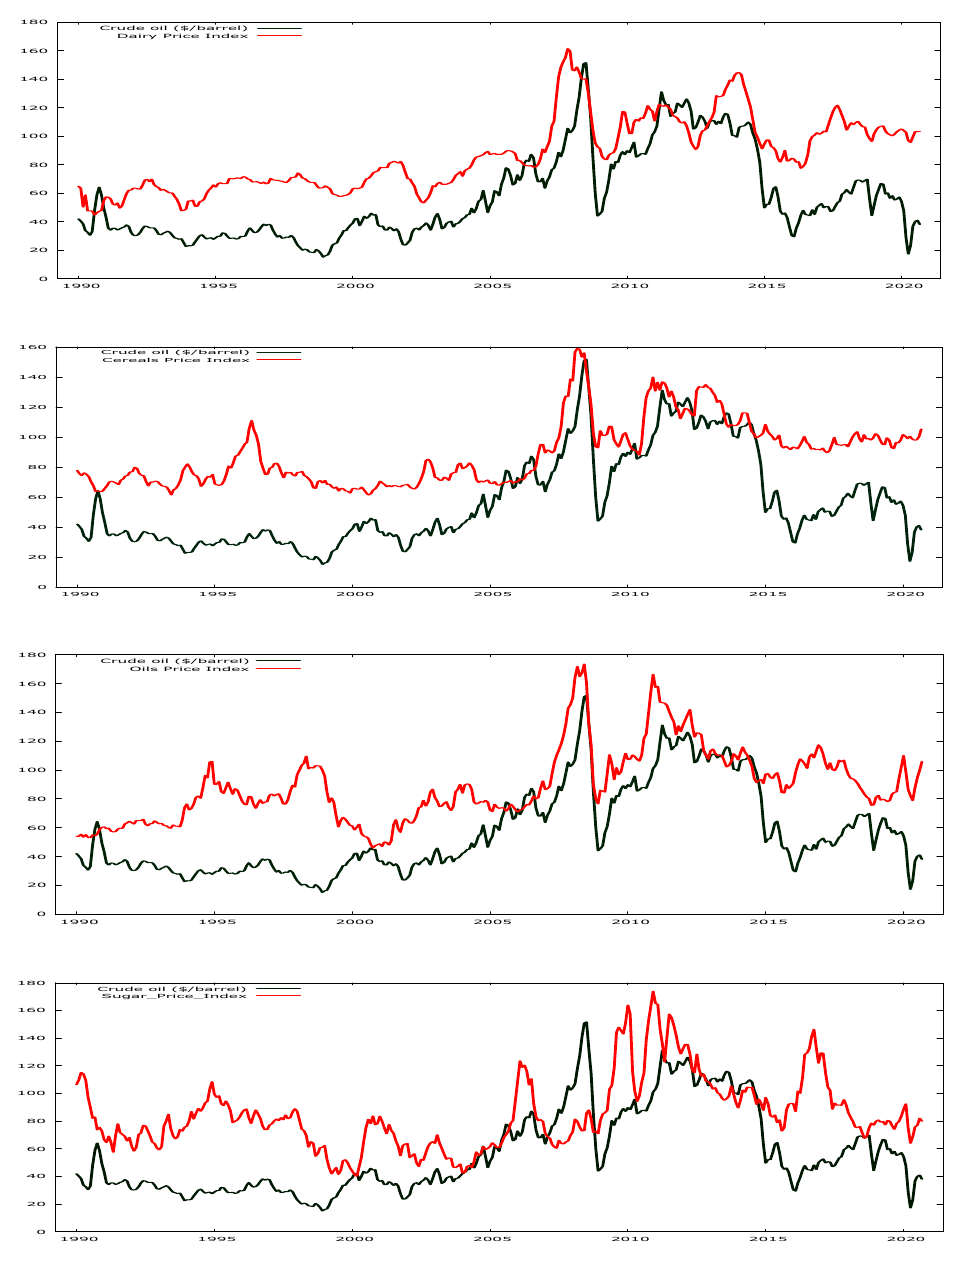
Figure 2. Monthly food price indices. Source: based on [9,43]. Table 2. Correlation coefficients between crude oil and food price indices.